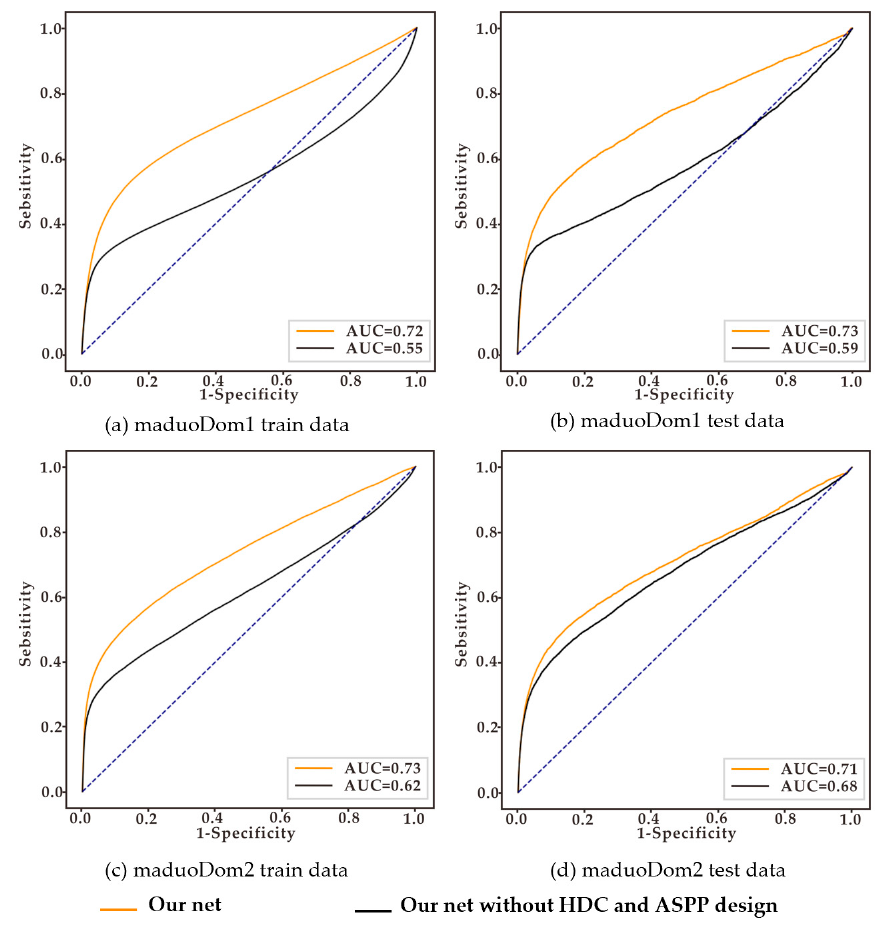
Figure 9. ROC curves of the models.